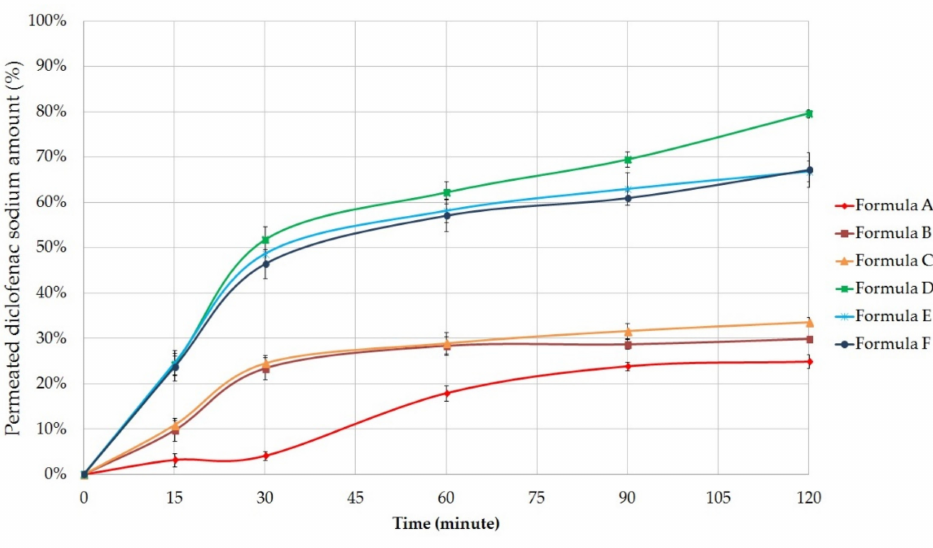
Figure 3. In vitro permeation profile of diclofenac sodium across isopropyl myristate (IPM) impregnated cellulose acetate membrane from the formulations. Bars represent mean ± S.D. ( n = 6).